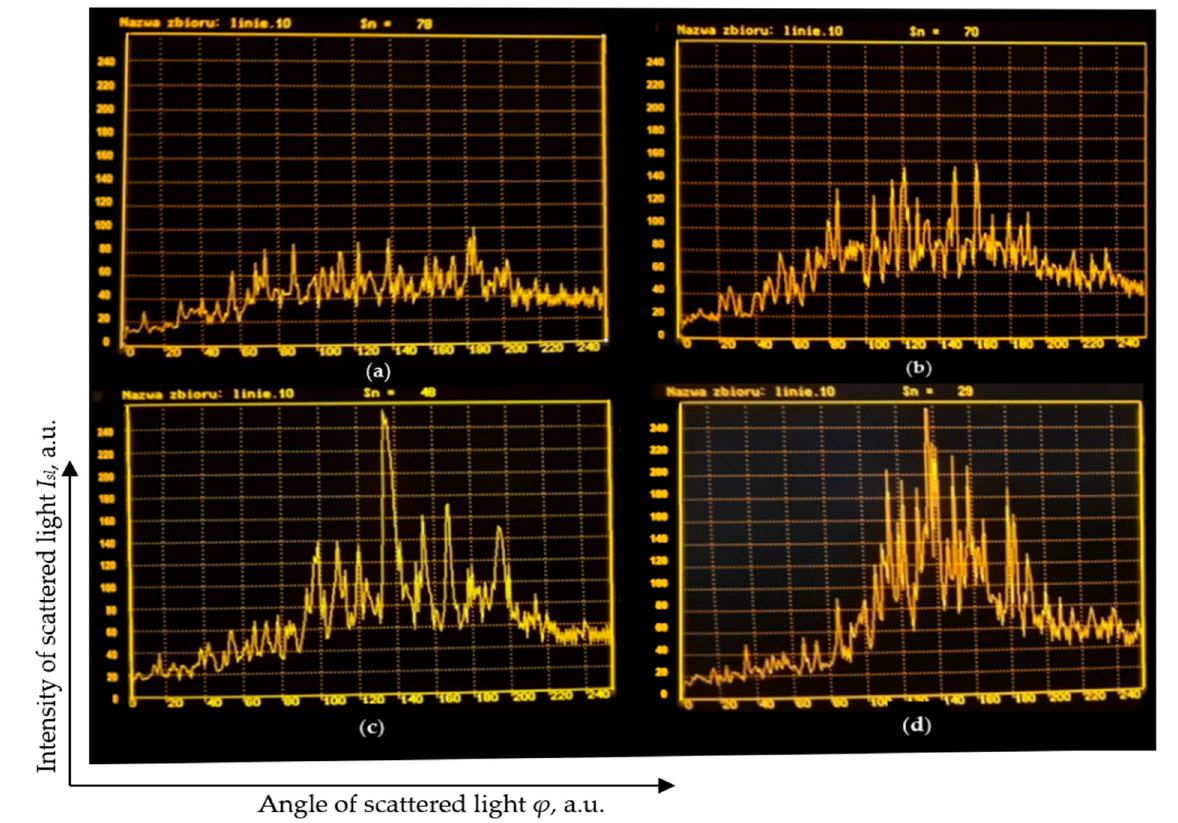
Figure 12. The angle distributions of the scattered light intensity obtained for sample without CDF machining ( a ); after 45 min of smoothing: without movement (b ); with rotational movement ( c ); with rotation and oscillating movement ( d ).